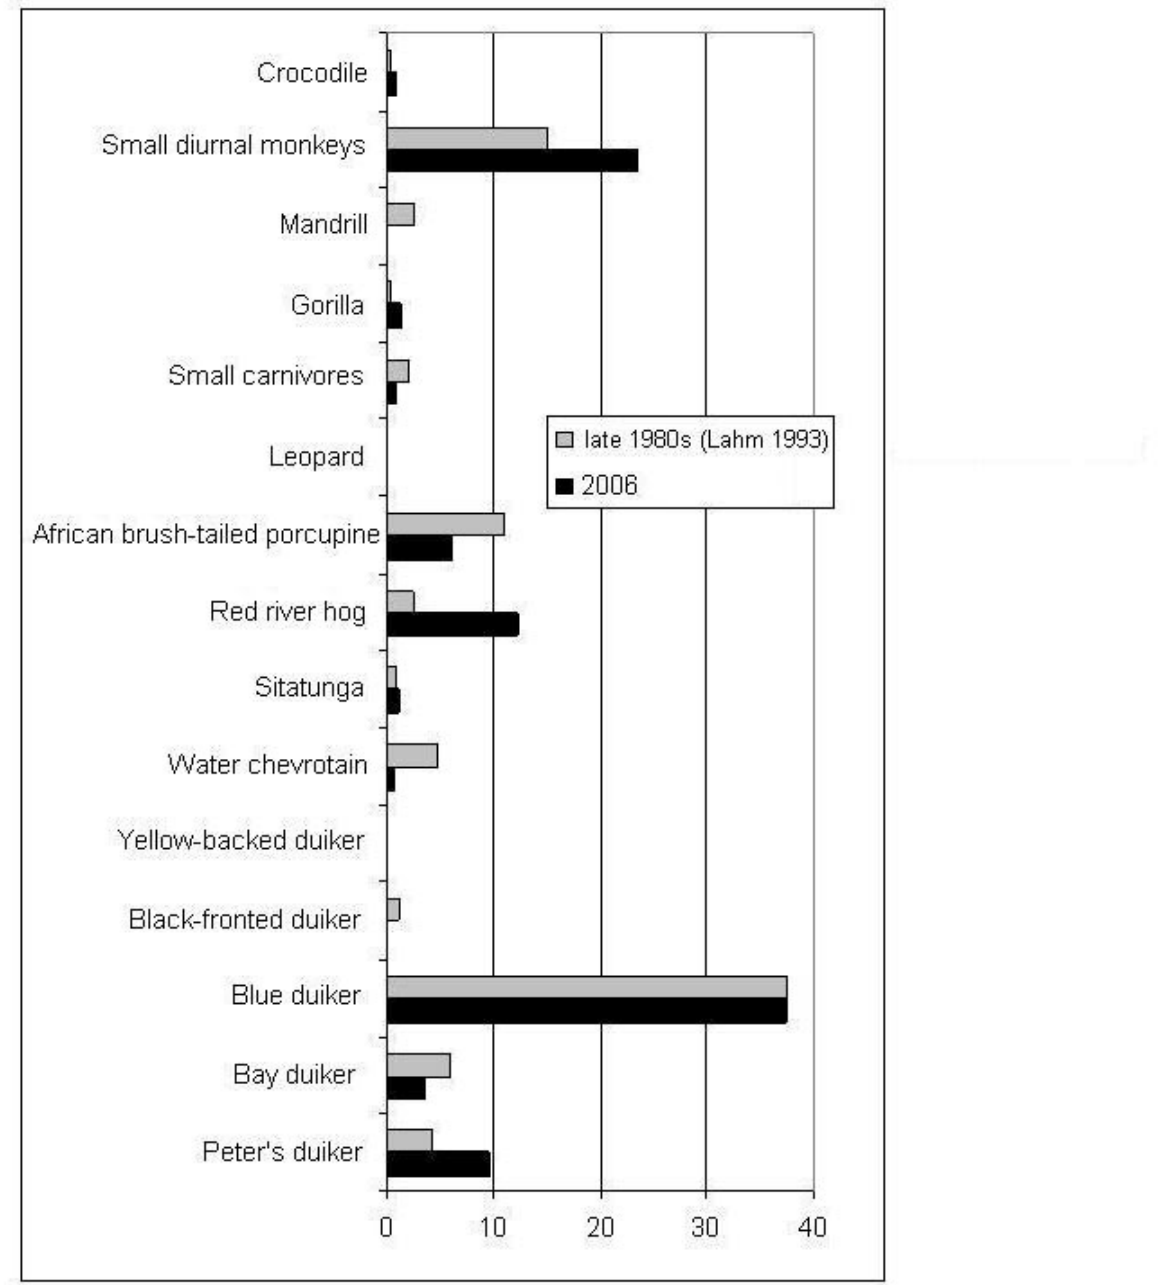
Fig. 5. Comparison of offtakes for each species between the late 1980s and 2006–2007 in villages in northeast